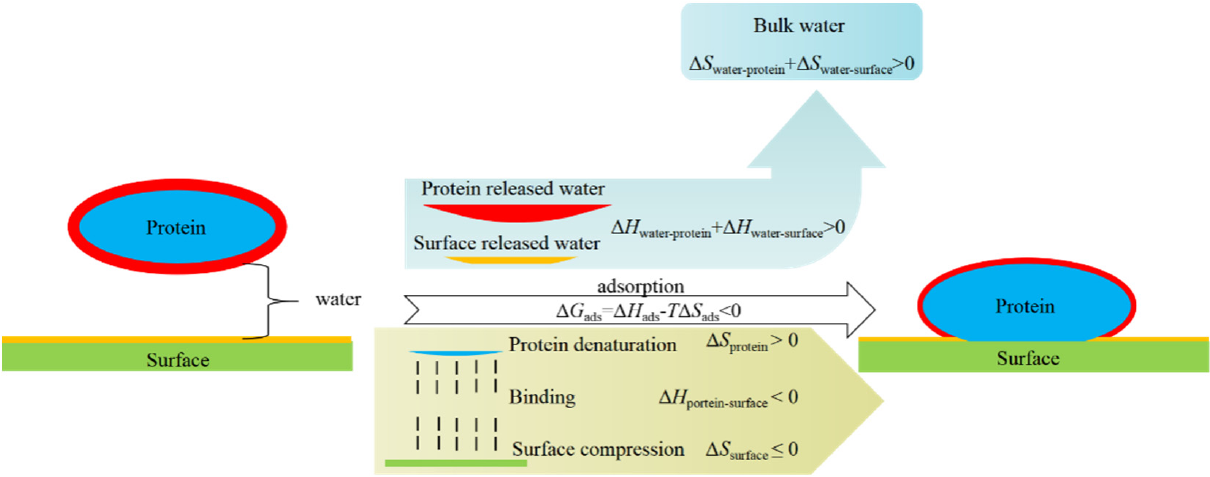
Figure 1. Scheme of mechanisms for nonspecific protein adsorption.